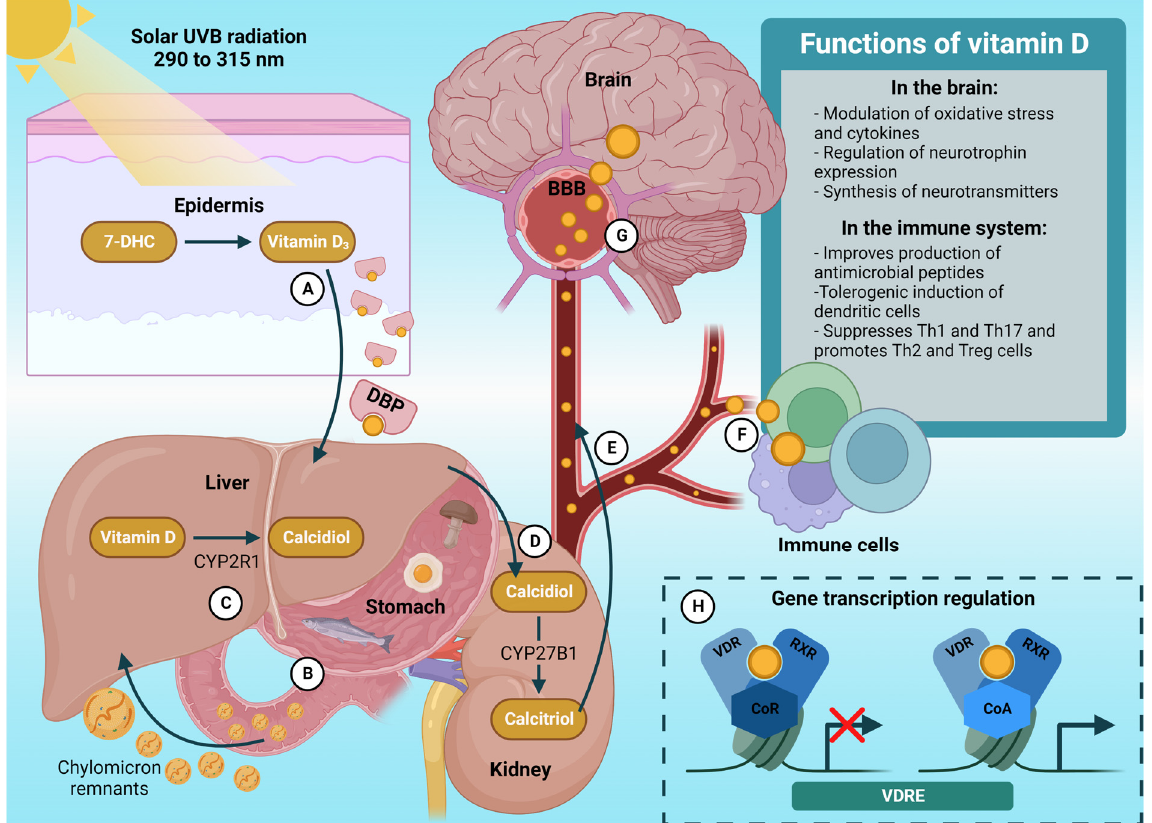
Figure 1. Metabolism, signaling, and functions of vitamin D. ( A ) Vitamin D 3 synthesized in the skin binds to DBP for its transport into circulation. ( B ) Dietary vitamin D (ergocalciferol or cholecalciferol) is incorporated into chylomicrons that promote its absorption and transport to the liver. ( C ) Vitamin D 2 and D 3 are metabolized in the liver by CYP2R1 for the formation of calcidiol. ( D ) In the kidneys, calcidiol is metabolized to calcitriol by CYP27B1. ( E ) Calcidiol is mobilized in the circulation for extrarenal metabolism, while calcitriol is mobilized to exert endocrine functions. ( F ) Calcidiol can be metabolized in immune cells (macrophages and lymphocytes), which in turn express VDRs to exert paracrine and autocrine functions. ( G ) Calcidiol can cross the blood-brain barrier (BBB); moreover, calcitriol produced in the brain exerts several regulatory functions (based mainly on experimental studies). ( H ) Calcitriol interacts with its nuclear receptors to form a complex (VDR– RXR) on VDREs. This complex in collaboration with nuclear corepressors or coactivators, regulates the transcription of target genes. UVB, ultraviolet-B; 7-DHC, 7-dehydrocholesterol; Vitamin D 2 , er- gocalciferol; Vitamin D 3 , cholecalciferol; DBP, vitamin D binding protein; CYP2R1, cytochrome P450 Family 2 Subfamily R Member 1 (25-hydroxylase); CYP27B1, cytochrome P450 Family 27 Subfamily B Member 1 (25-hydroxyvitamin D-1 alpha hydroxylase); VDR, vitamin D receptor; RXR, retinoid X receptor; CoR, nuclear corepressors; CoA, nuclear coactivators; VDRE, vitamin D response ele- ment; Th, T helper cells; Tregs, T regulatory cells. 3.3. Vitamin D Is a Bioactive Agent in the Brain Although VDR was initially identi fi ed in tissues related to calcium and phosphorus homeostasis (intestine, bones, kidneys, and parathyroid gland), it is now recognized that VDR is also present in brain cells (astrocytes, microglia, and neurons) and immune system cells (T cells, B cells, and macrophages). Therefore, vitamin D can perform several brain immunoregulatory functions [42–45]. Some authors have demonstrated possible cogni- tive-enhancing e ff ects of vitamin D, which may re fl ect a direct action in the brain rather than a result of secondary systemic e ff ects. Indeed, in experimental rodent models, vita- min D has direct neuroprotective actions and can reduce some biomarkers of brain aging, i.e., optimal levels of vitamin D stabilize myelin structure and enhance synaptic vesicle recycling and transcription factors facilitating cognitive processes [46–48]. Moreover,